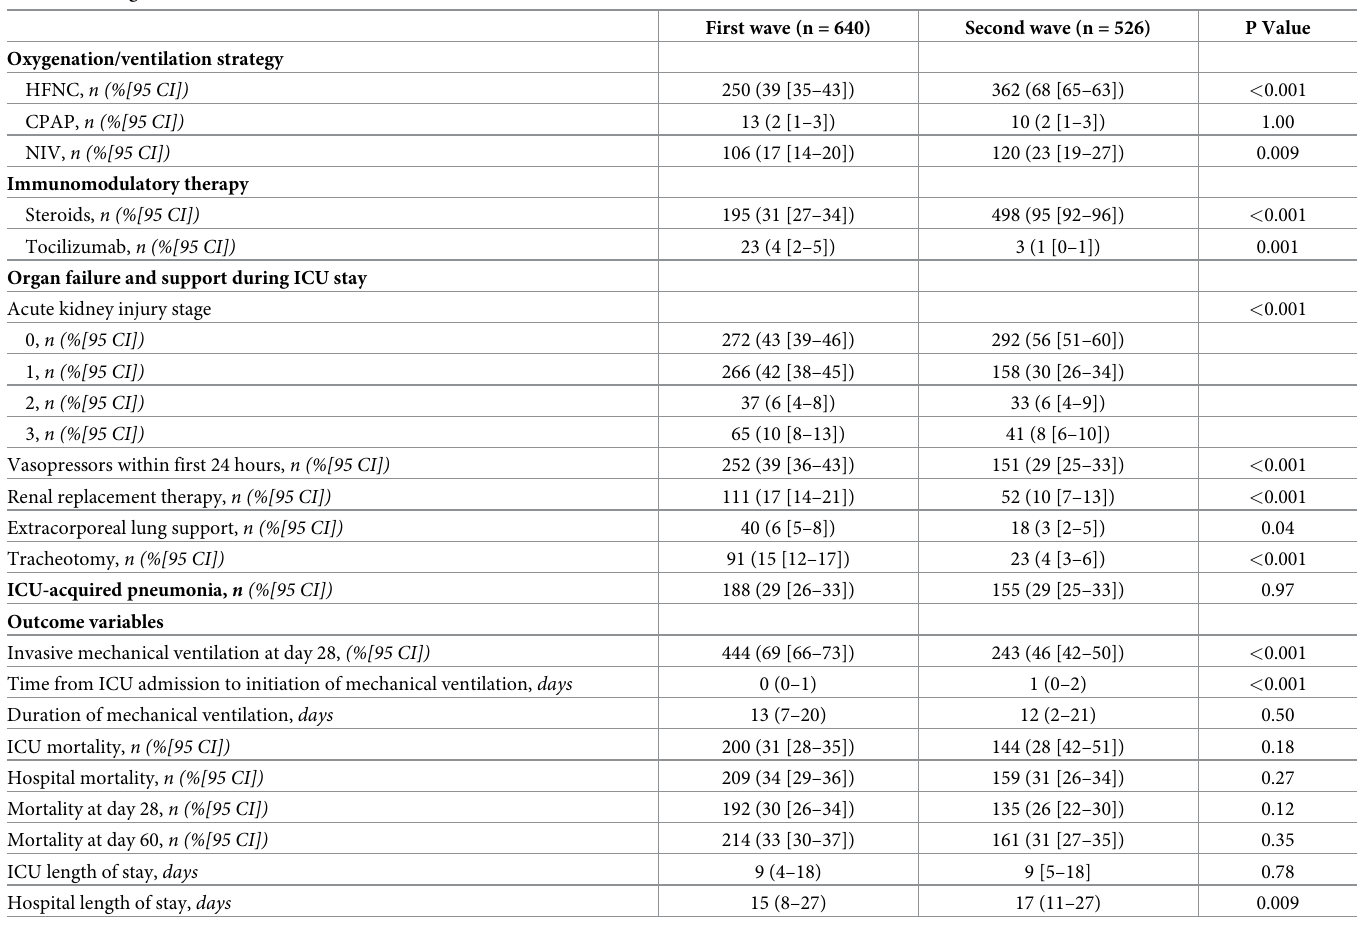
Table 2. Management and